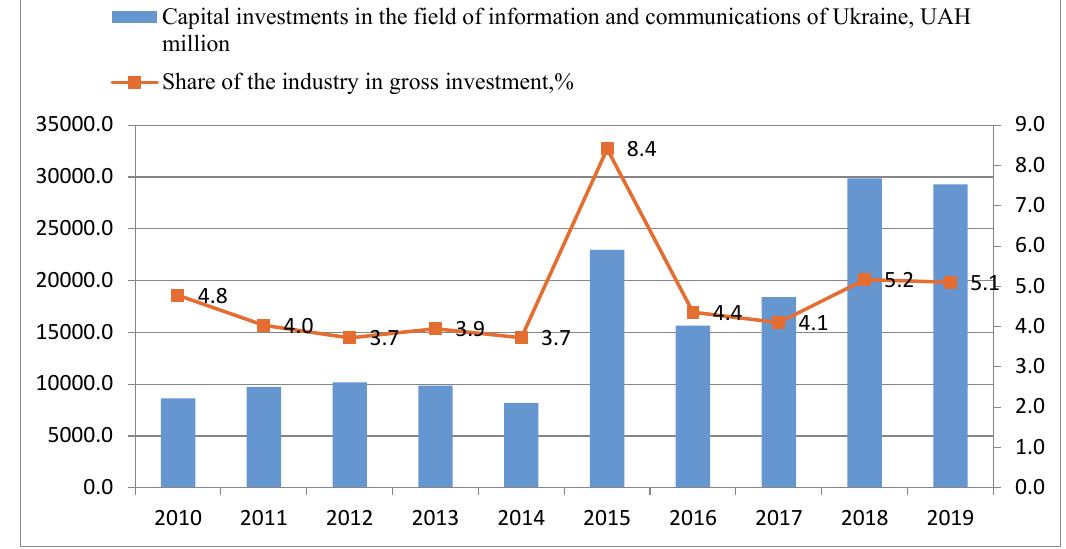
Fig. 2. Dynamics of capital investments in the field of information and communications of